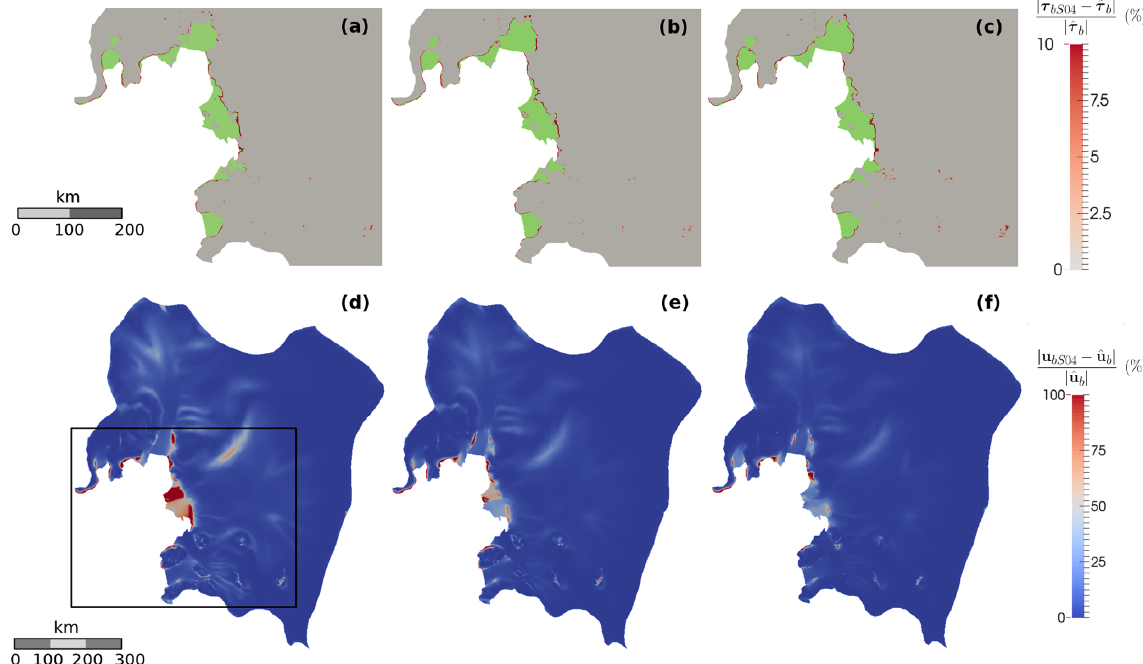
Figure 5. Relative differences (%) between the fields of τ b (first row) and u b (second row) produced by the linear Weertman law and the non-linear Schoof law associated with C max = 0 . 4 and the C S distributions identified through Eq. (22) or interpolated, for the inferred states I R – panels (a) and (d) –, I R – panels (b) and (e) – and I R – panels (c) and (f) . Panels of the first row zoom into the neighbourhood γ, ∞ γ, 100 γ, 1 of ice shelves (shown in green), where the relative differences in τ b are concentrated, while panels on the second row show the whole ASE. The zoomed-in area is highlighted with a black box on panel (d)